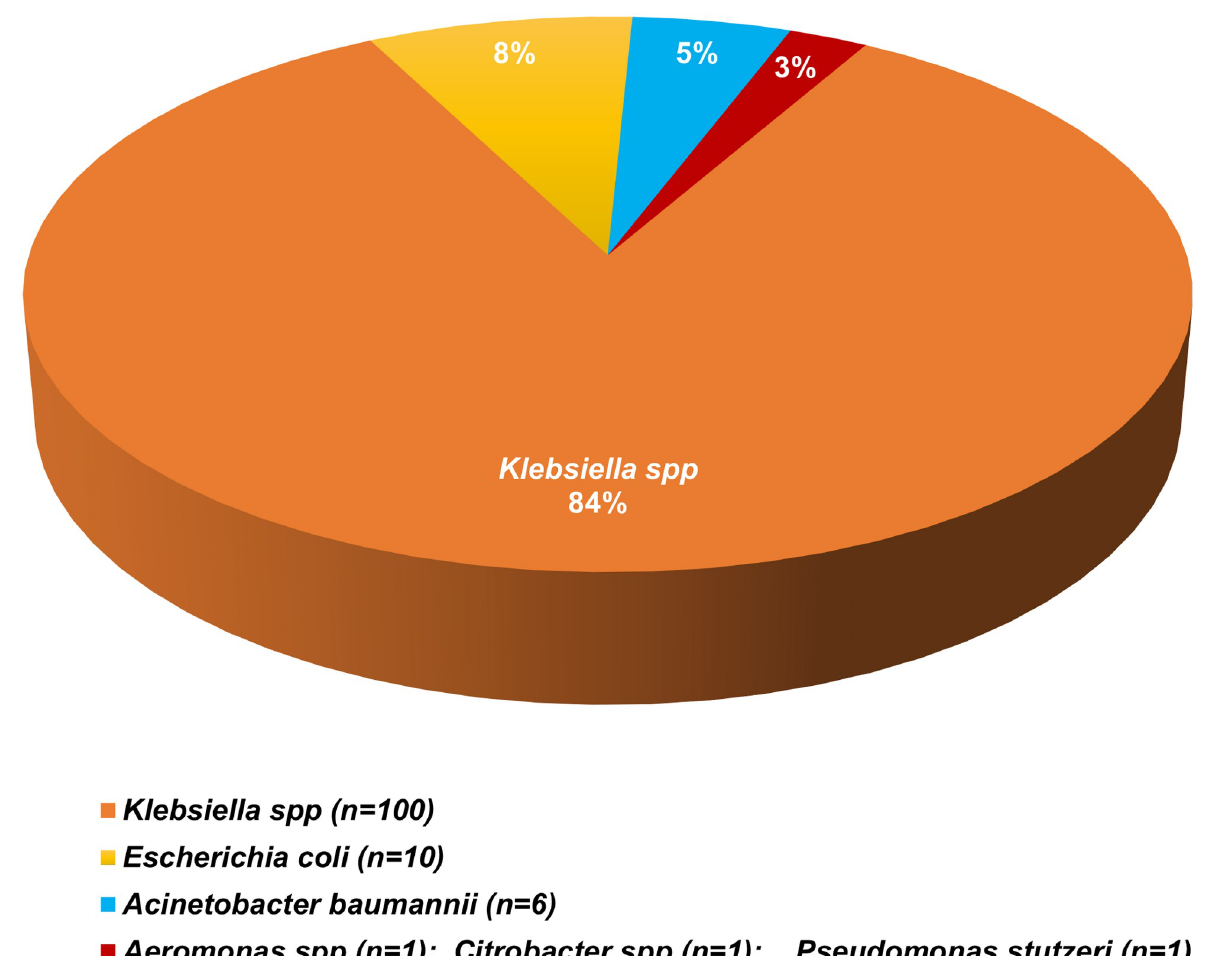
Fig 3. Prevalence of gram-negative bacterial species. Among the 119 newborns, the majority of gram-negative isolates identified were Klebsiella spp , followed by Escherichia coli and Acinetobacter baumanni